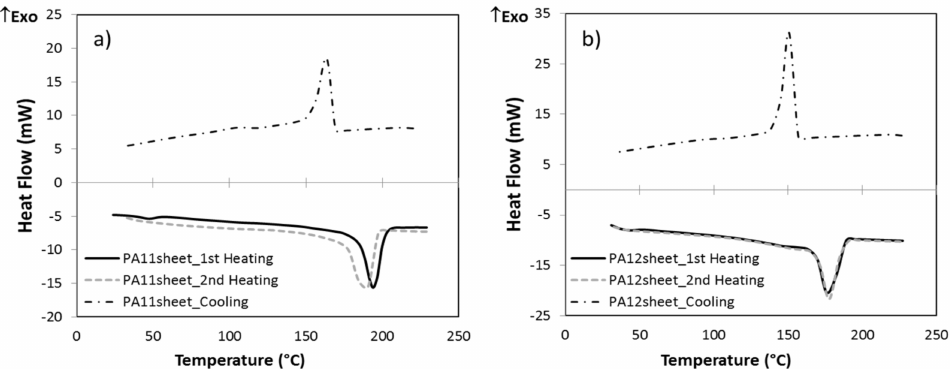
Figure 11. DSC thermograms of PA sheets (heating rate: 20 ◦ C/min): ( a ) PA11, ( b )